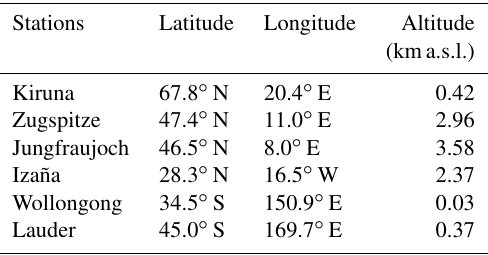
Table 1. List of the FTIR stations used for the validation of IASI TOCs and partial ozone columns. The latitude, longitude and alti- tude above sea level in kilometers (kma.s.l.) are provided for each